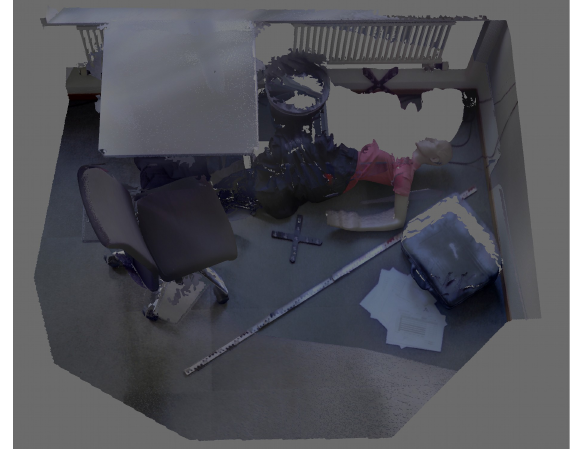
Figure 4. Colourised laser scan model of the scene. The holes are visible especially in the top right corner behind the